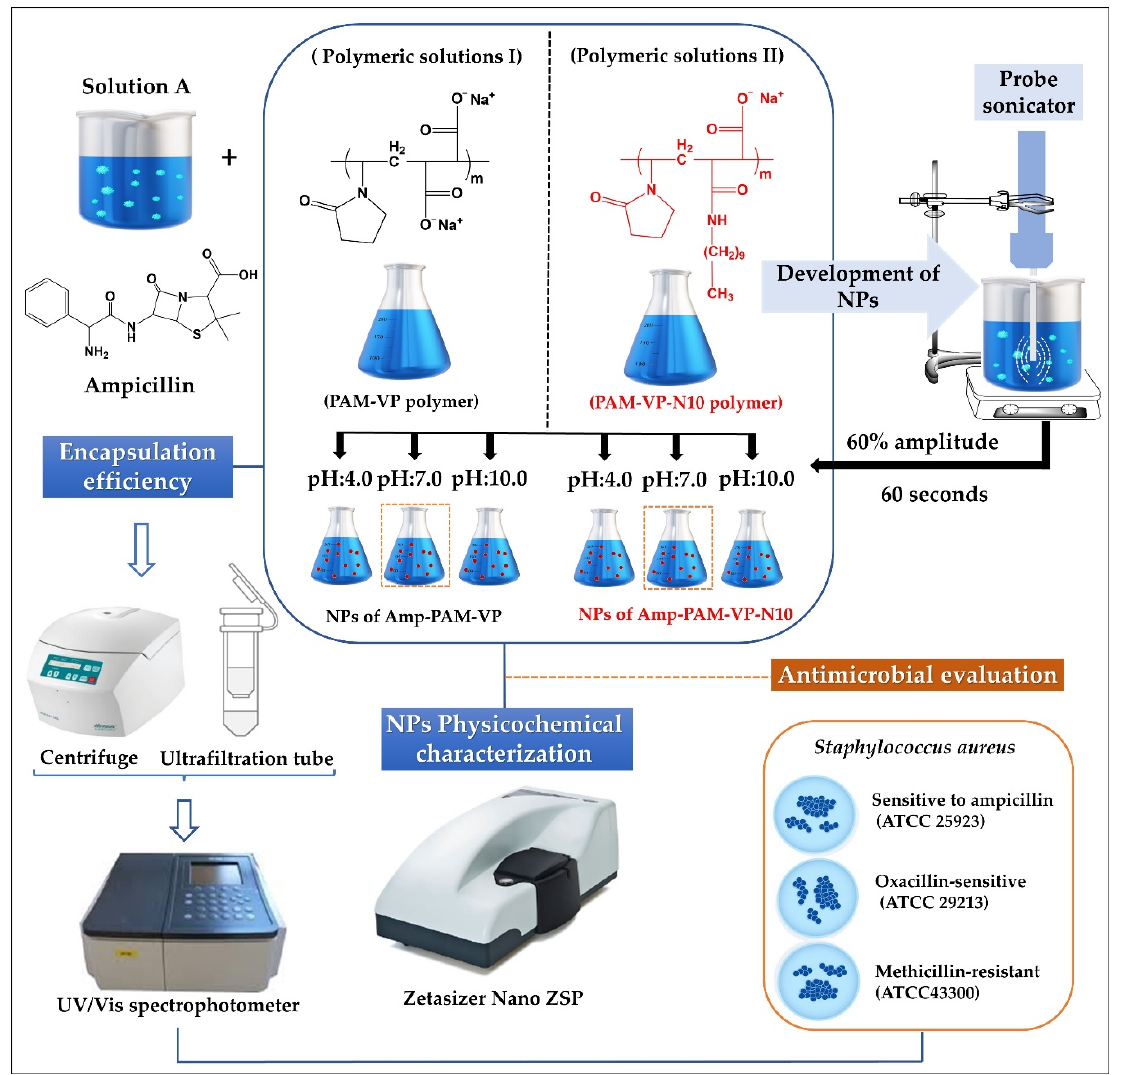
Figure 1. Scheme of elaboration process, physicochemical characterization, and antimicrobial eval-